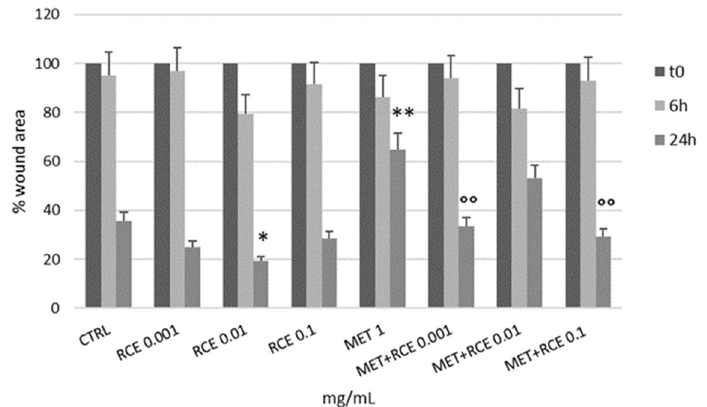
Figure 4. Wound healing activity on fibroblasts of RCE (RC-P extracts) after 6 and 24 h of treatment, in the absence and presence of MET (6 α -methylprednisolone). Two-way ANOVA, followed by Tukey post-hoc: * p < 0.05 vs. ctrl; ** p < 0.01 vs. ctrl; °° p < 0.01 vs. MET.